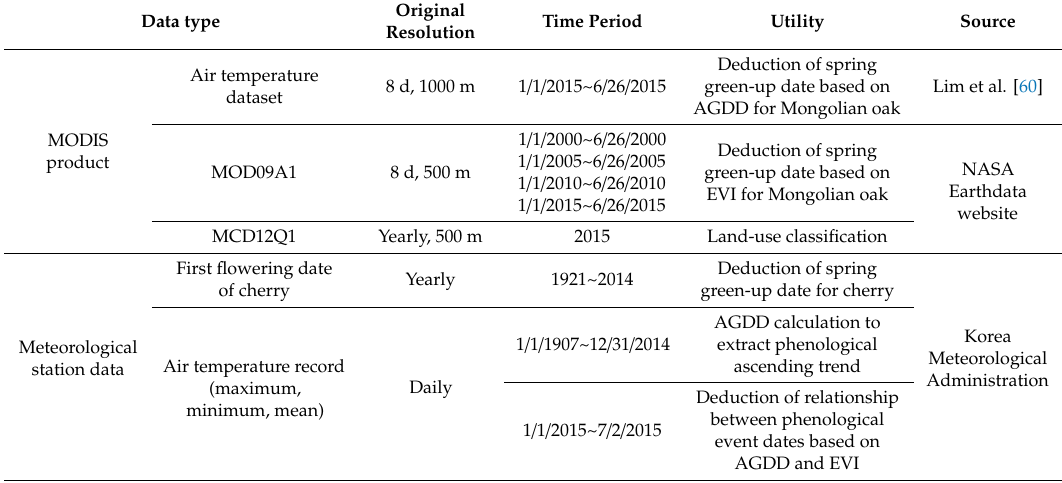
Table 1. A summary for data used in the